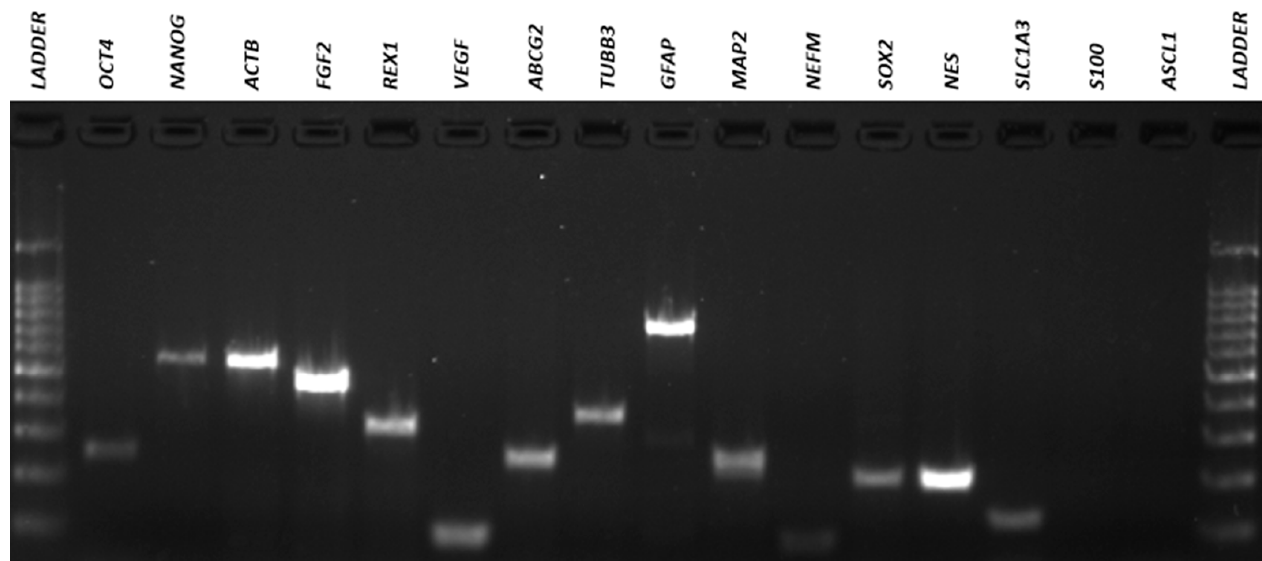
Figure 7. ADMSCs electrophoresis gel. RT-PCR for amplification of OCT4 (292bp), NANOG (578 bp), ACTB (564 bp), FGF2 (482 bp), REX1 (344 bp), VEGF (107 bp), ABCG2 (270 bp), TUBB3 (385 bp), GFAP (789 bp), MAP2 (241 bp), NEFM (98 bp), SOX2 (224 bp), NES (220 bp), SLC1A3 (136 bp), S100 (261 bp) and ASCL1 (122 bp) genes in ADMSCs. ADMSCs, adipose- derived mesenchymal stem cells.